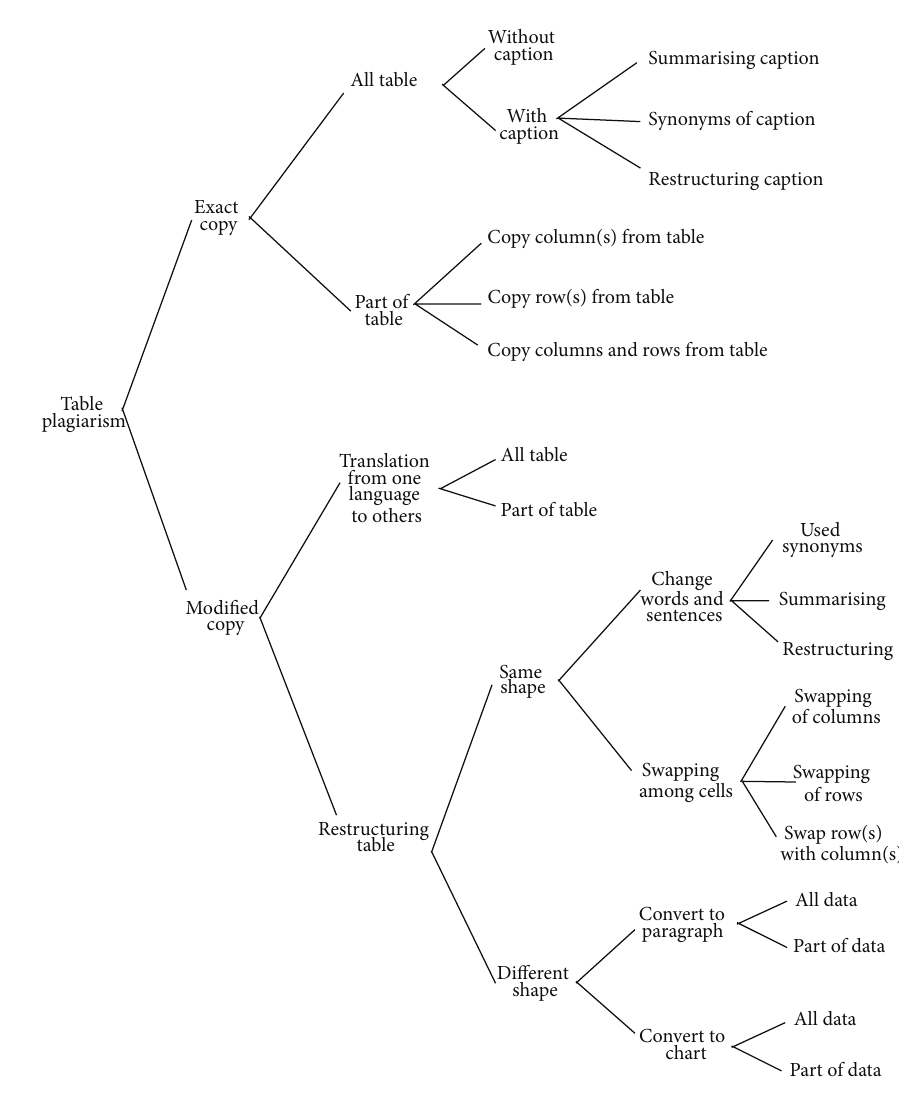
Figure 3: Taxonomy of table